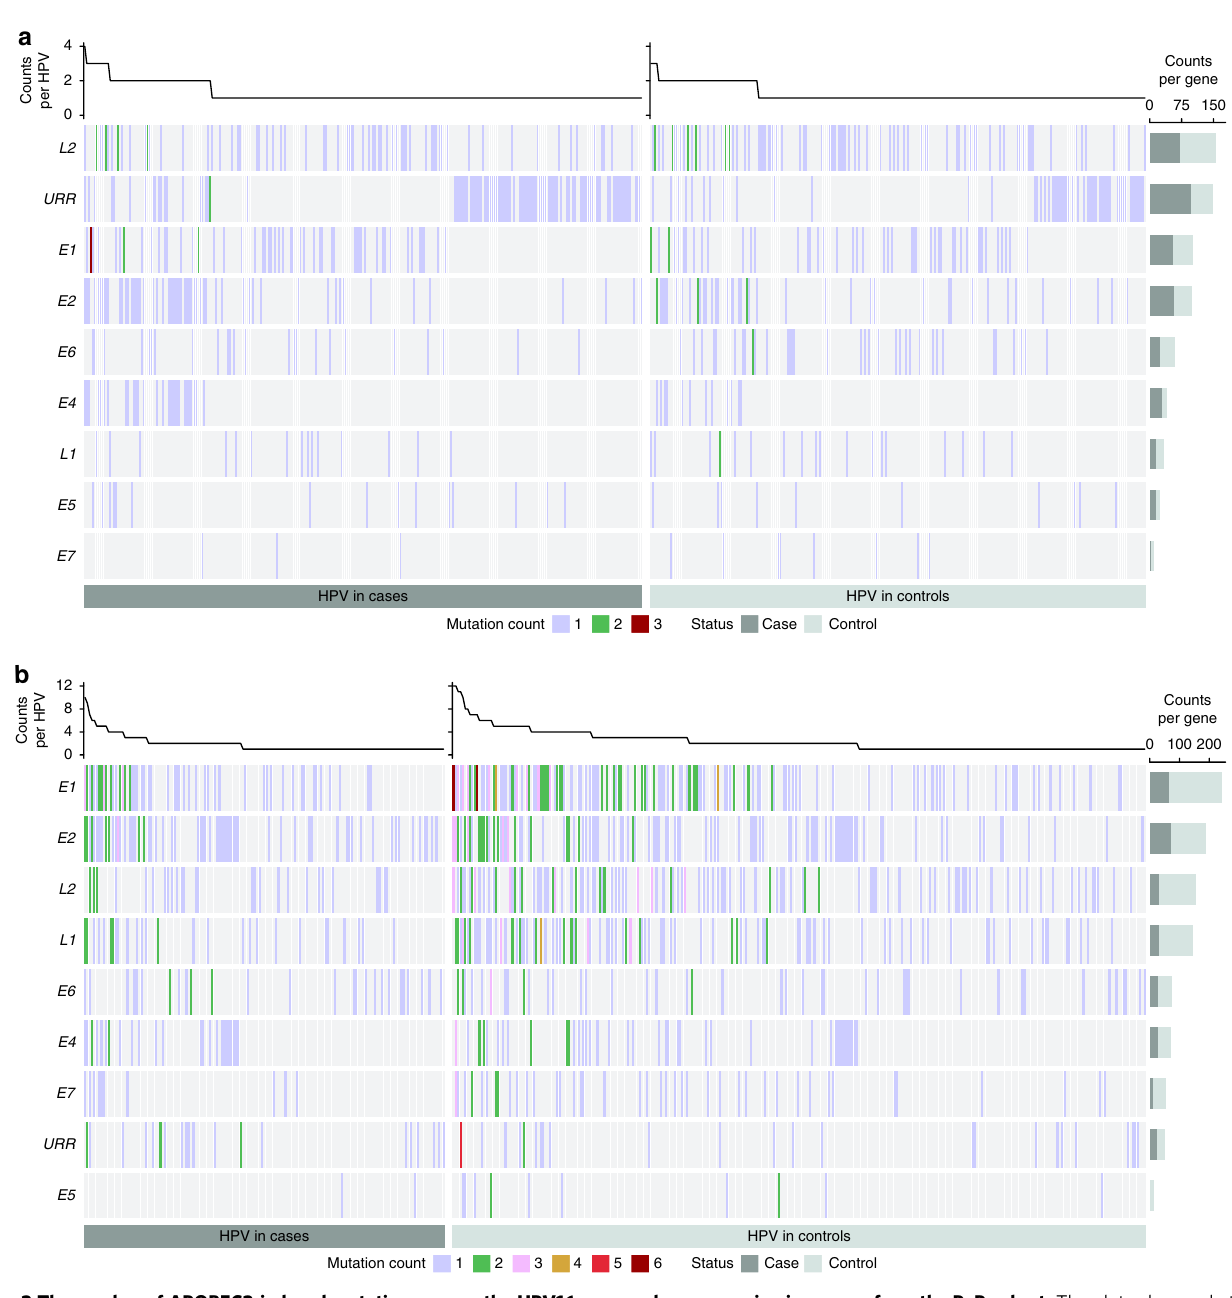
Fig. 3 The number of APOBEC3-induced mutations across the HPV16 genome by gene region in women from the PaP cohort. The plots show only the cases and controls with one or more APOBEC3-induced mutations at a ( a ) high variant allele fraction (VAF) and ( b ) low VAF. Each vertical line represents a sample with at least one APOBEC3-induced mutation, colored by the number of mutations observed, as 1 – 3 (see legend), per viral gene region. Samples with no APOBEC3-induced mutations are not illustrated; the size of the case and control panels correspond to the number of individuals with at least one APOBEC3-induced mutation. The samples are organized along the x -axis by status (case vs. control). Cases are cervical intraepithelial neoplasia grade 3 and cancer cases (CIN3 + ). The right y -axis represents viral gene regions with the overall frequency of APOBEC3 mutations summarized, taking into account the sample sizes of the cases/controls and potential APOBEC3-mutable sites, for CIN3 + cases in dark gray and controls in light gray. The top panel histogram summarizes the total APOBEC3-induced mutations for the cases and controls across the HPV16 genomes. URR upstream regulatory region, E6 early gene 6, E7 early gene 7, E1 early gene 1, E2 early gene 2, E4 early gene 4, E5 early gene 5, L2 late gene 2, L1 late gene